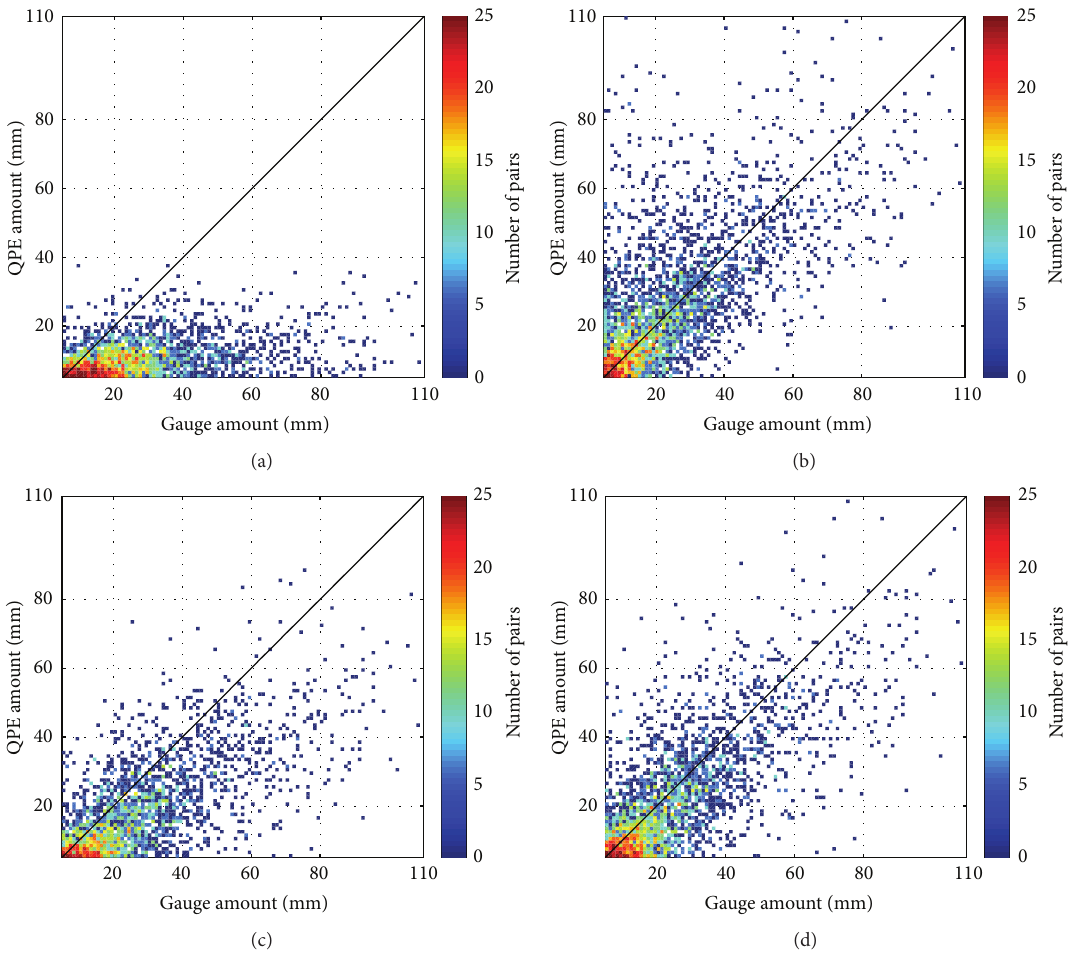
Figure 11: Similar to Figure 8, only those QPE-gauge pairs in which gauge’s heights are 500 m or higher above sea level are selected. There are a total of 6276 QPE-gauge pairs used in this